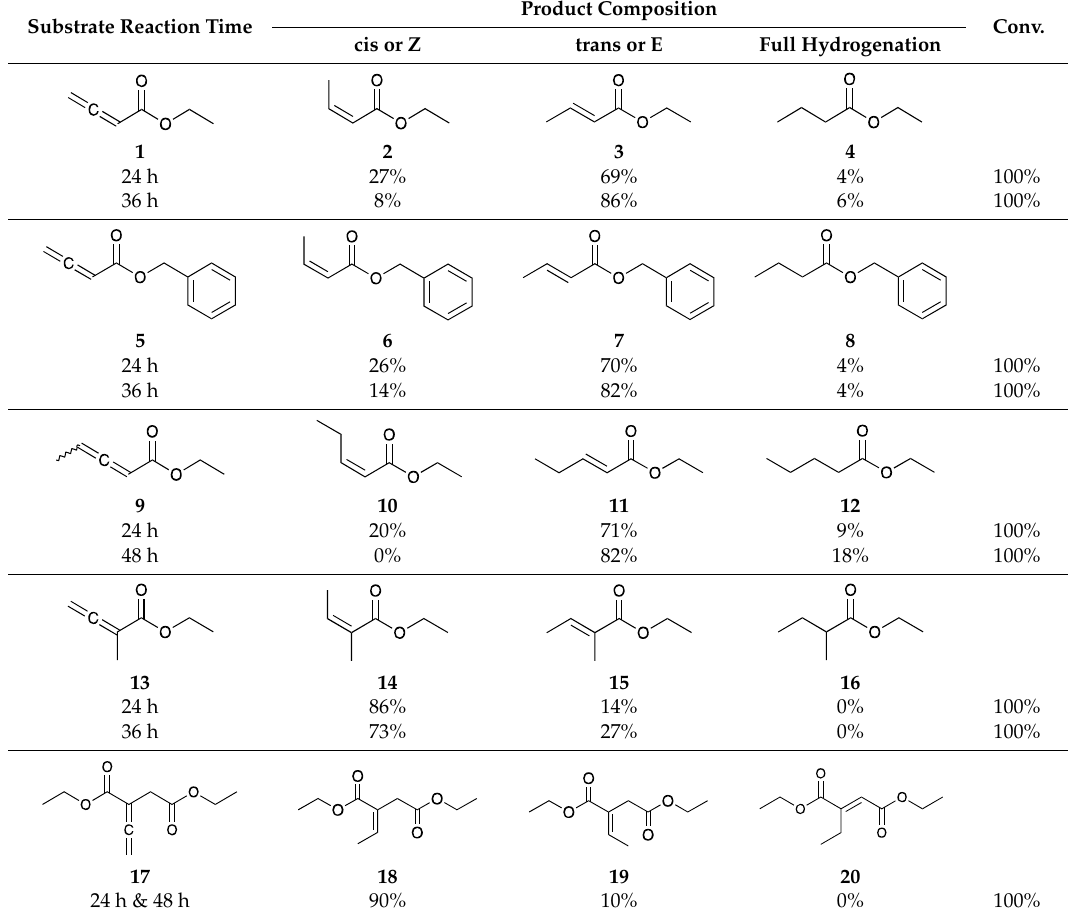
Table 2. Catalytic reaction of conjugated ester functionalized allenes a .